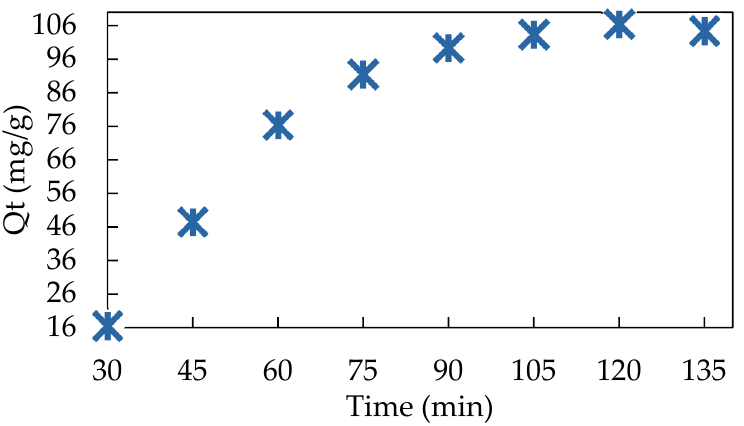
in 35 min [15]. In another previous study, Acid Blue 193 was removed in 60 min from Amberlite IRA 400 [16].